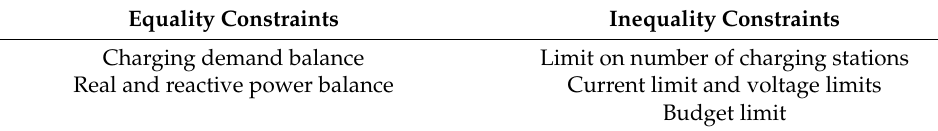
Table 3. Various constraints of placement problem [102].